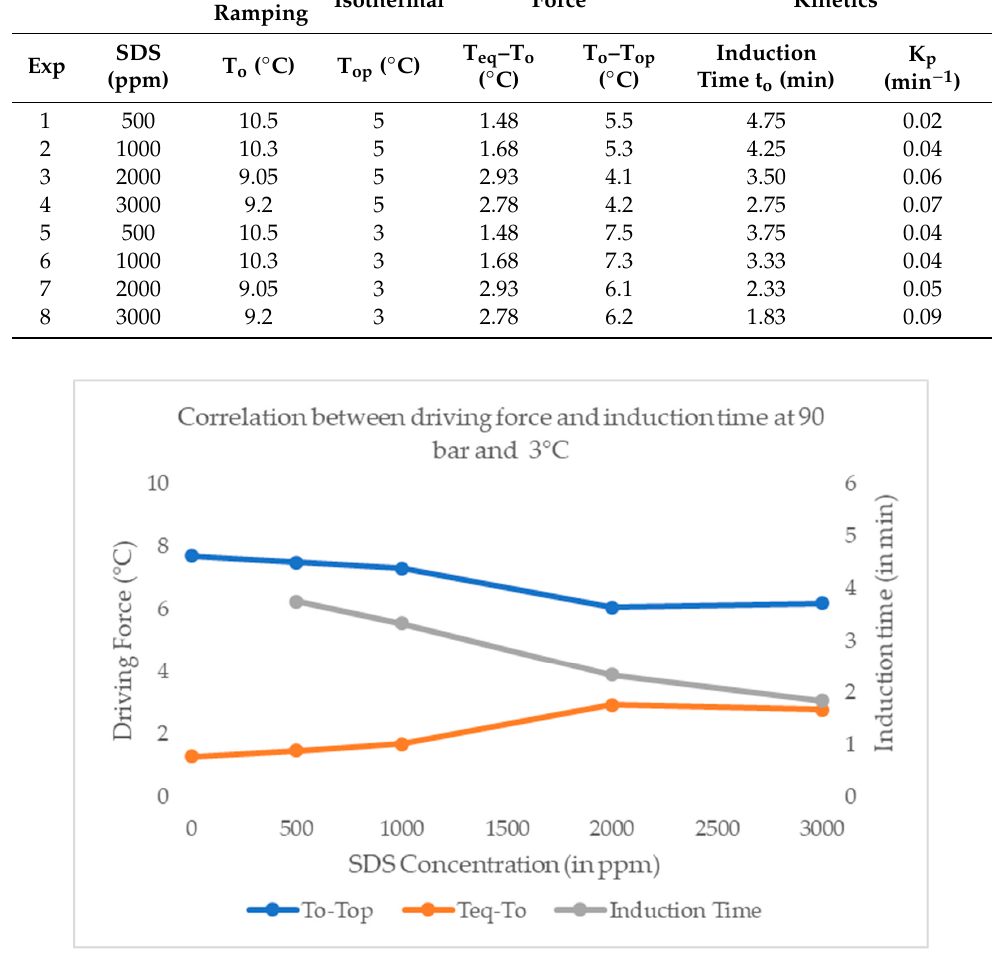
Figure 13. Correlation between driving force and induction time for T op = 3 ◦ C. Induction time varies with different driving forces in isothermal and constant ramping temperature schemes.